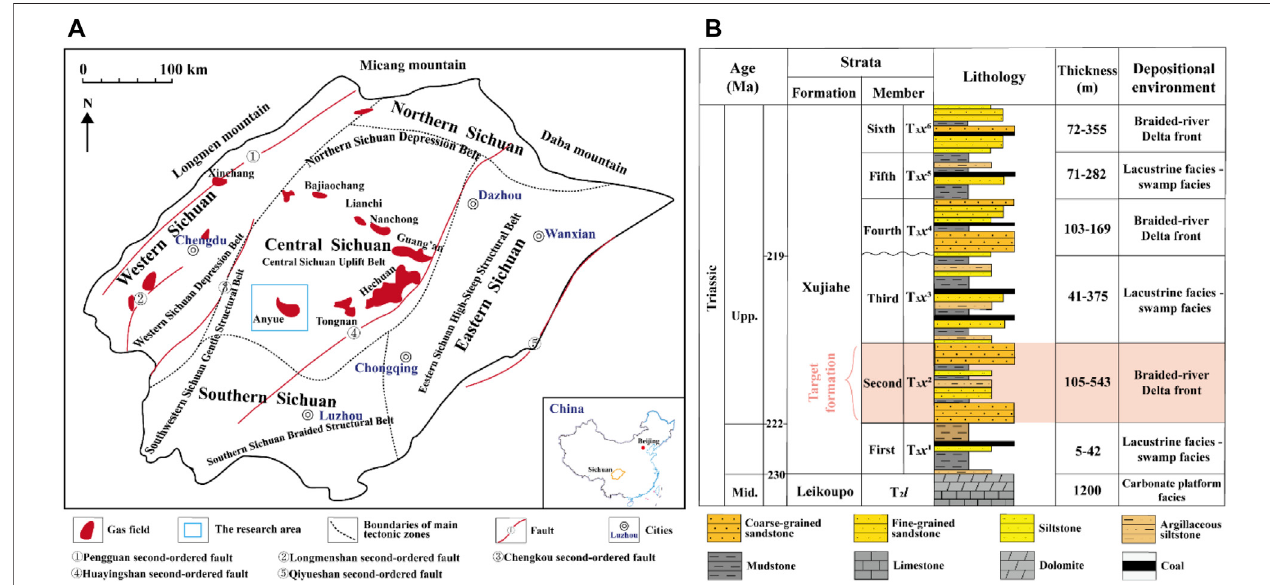
FIGURE 1 | (A) Geological map, demonstrating: I. the tectonic units of the Sichuan Basin; II. the location of main Xujiahe gas fi elds; III. the location of our research area. (B) The stratigraphic setting of the Xujiahe Formation.